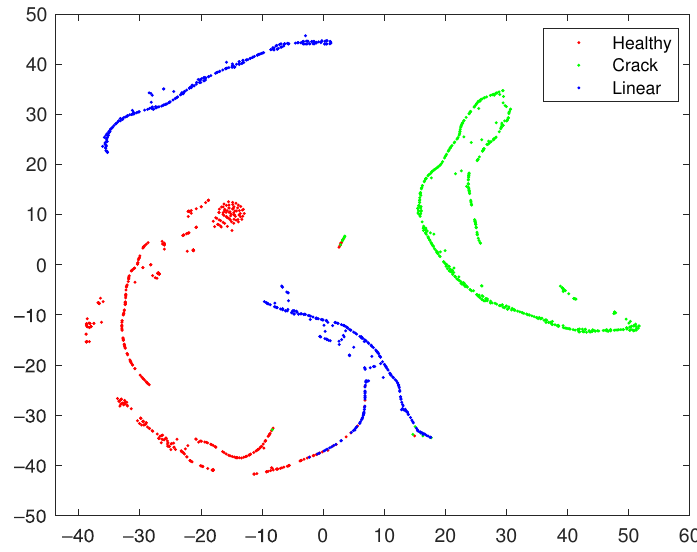
Figure 18. t-DSNE visualization of the final